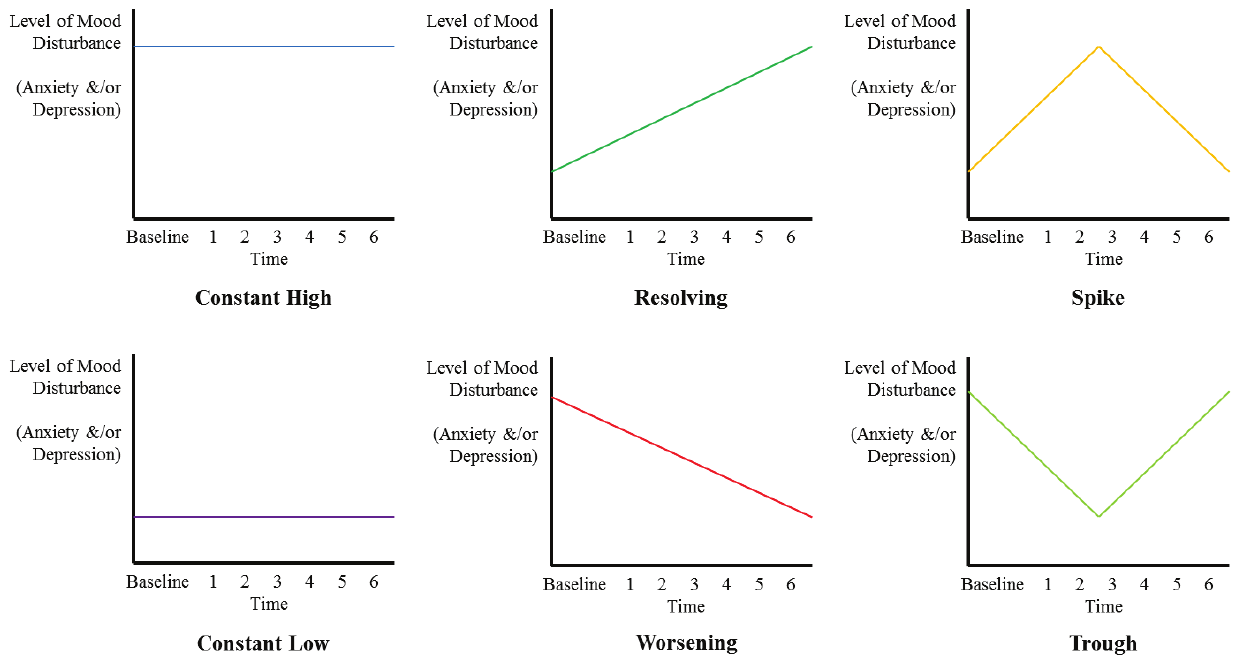
Figure 2. Anticipated “patterns” of anxiety or